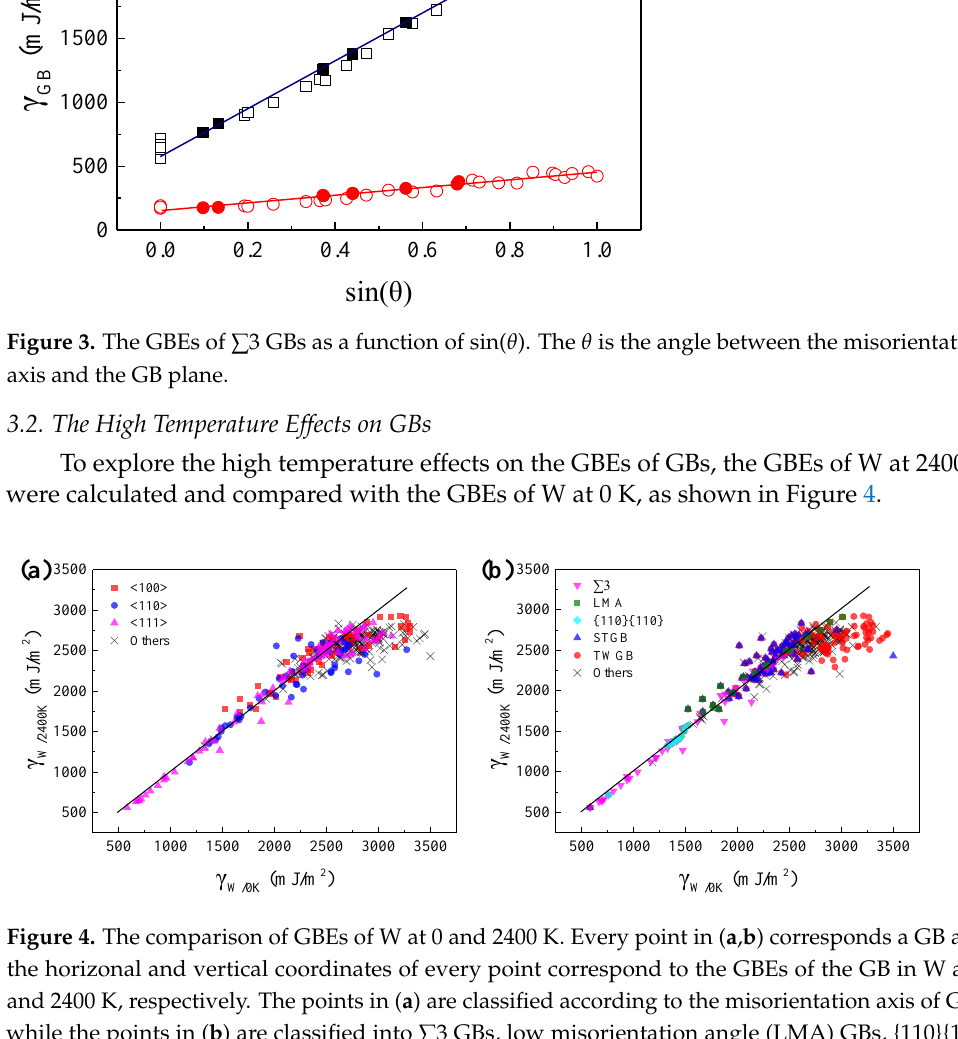
Figure 5. The GB microstructures of Σ11{332}{332} for ( a ) W at 0 and ( b ) W at 2400 K. The structure units of the GBs are highlighted by red polygons. The atoms arranged in body-centered cubic (BCC), face-centered cubic (FCC), hexagonal close-packed (HCP), and other patterns are colored by bule, green, red, and yellow, respectively. 3.3. The GBs with Lower GBE Many previous works have reported that the GBs show a strong preference for some special GB planes when the lattice misorientation of the two adjacent grains is specified [7 – 9,54,61 – 63]. It was speculated that these preferred GBs generally have lower GBE, and every preferred GB always has almost the lowest GBE of the GBs with the same lattice misorientation. Our calculations show that for GBs in Mo at 0 K, W at 0 K, W at 2400 K and β - Ti at 1300 K, the ∑9{110}{110}, ∑5{310}{310} , and ∑3{211}{211} have almost the low- est GBE of the ∑9 GBs, ∑5 GBs , and ∑3 GBs, respectively. In experiments, the ∑9 GBs of nanocrystalline W [9] , the ∑5 GBs of high purity iron [64] and the ∑3 GBs of ferrite [7] showed a strong preference for the {110}{110}, {310}{310}, and {211}{211} planes, respec- tively. This is in accordance with our calculations. Therefore, it was concluded that the